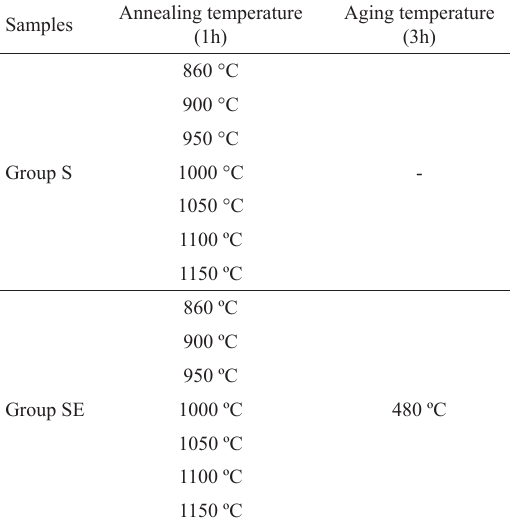
Table 2: Summary of heat treatments. Samples